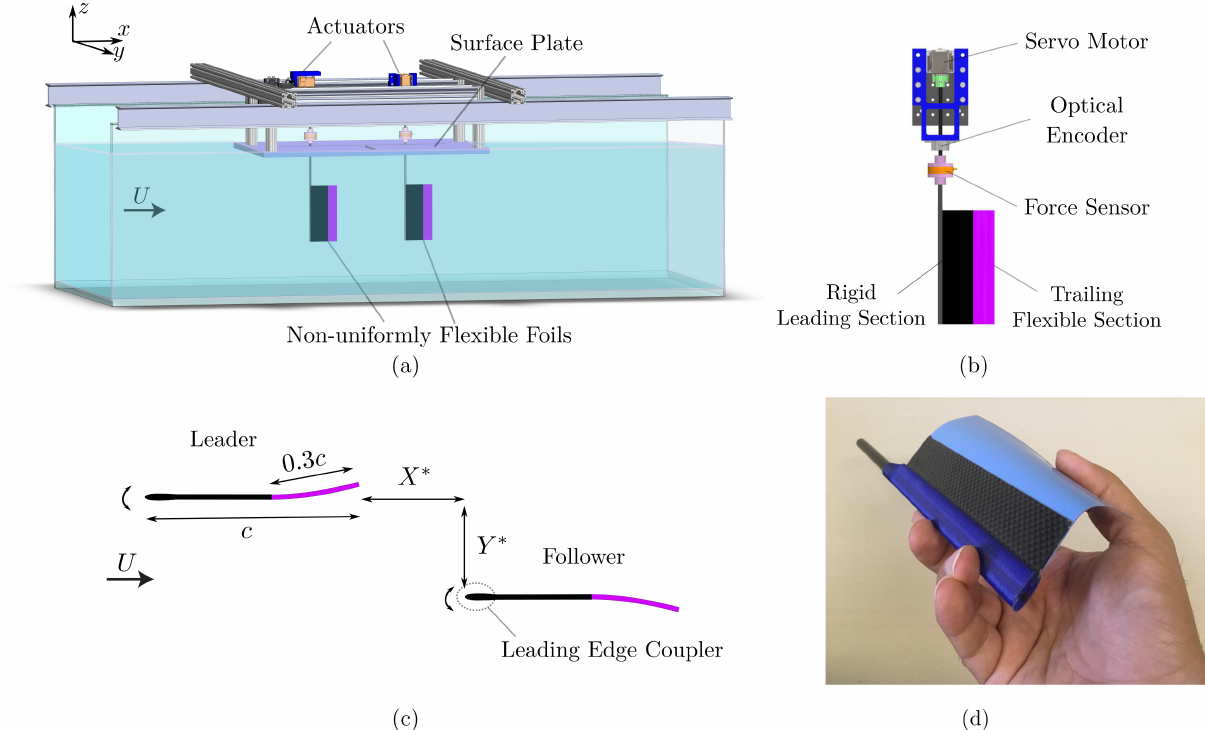
Figure 2. ( a ) Schematic of the water channel setup, ( b ) single pitching mechanism, ( c ) the flexible foils in a staggered arrangement, and ( d ) photograph of a non-uniformly flexible